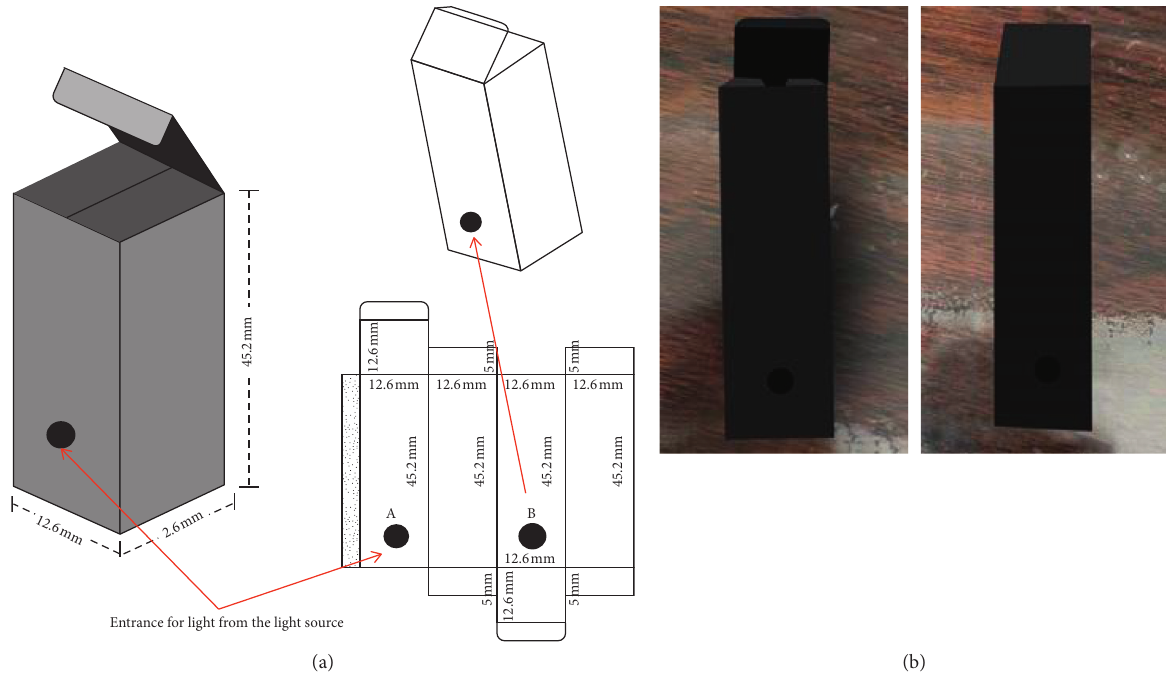
Figure 1: Schematic (a) and photo (b) of homemade cuvette